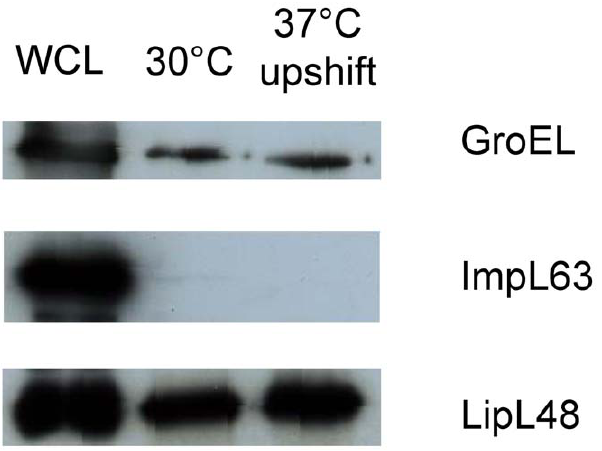
Figure 1. Western immunoblots showing whole cell lysate (WCL) from L.interrogans serovar Lai and TX-114 preparations from L.interrogans serovar Lai grown at 30 u C or upshift to 37 u C probed with antisera against GroEL, ImpL63 or LipL48. WCL samples were adjusted for equal protein loading.